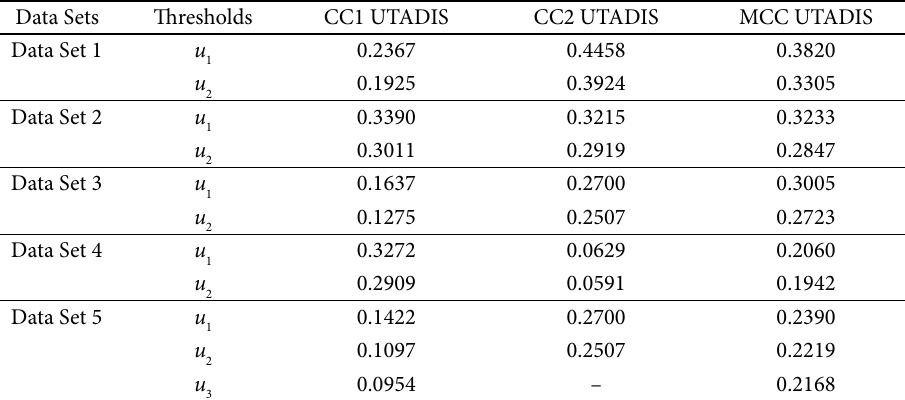
table 8. Utility thresholds